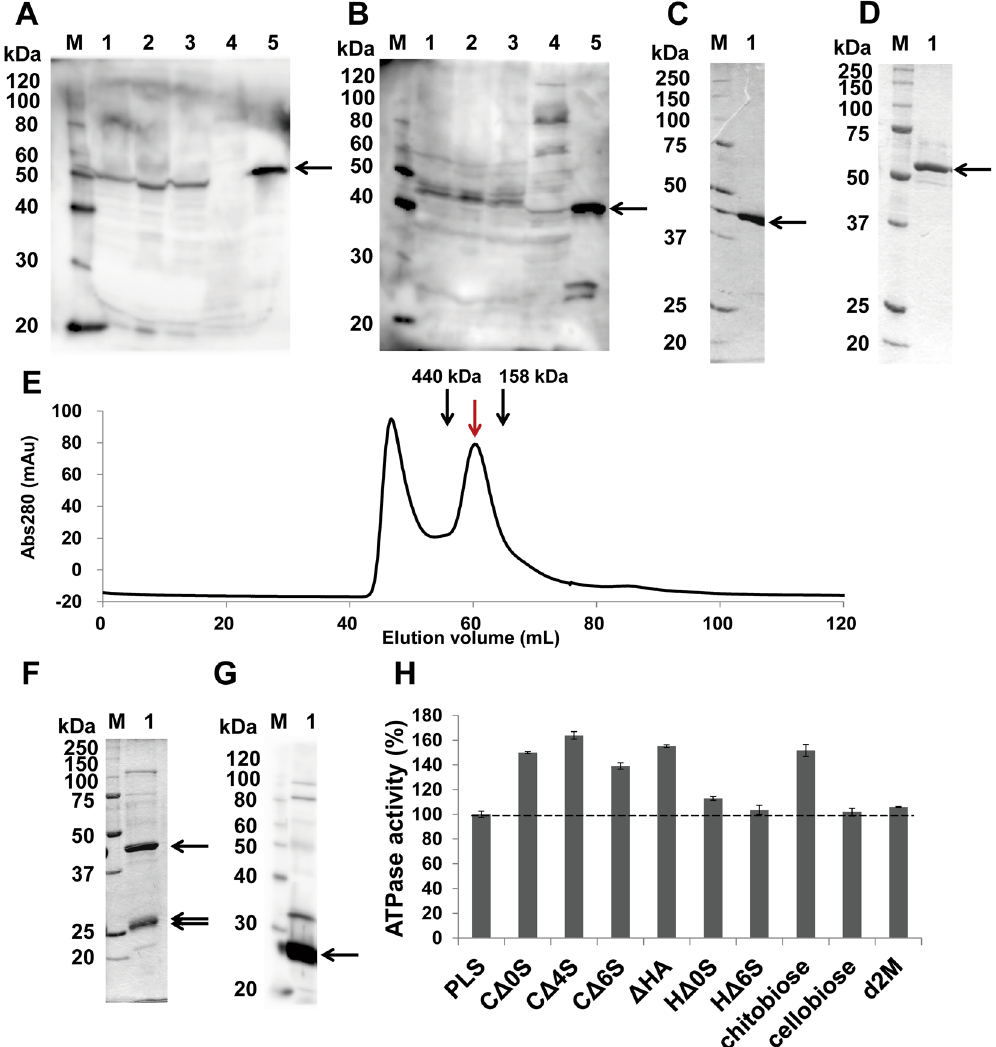
Figure 4. Expression and characterization of binding protein-dependent ABC transporter. SDS-PAGE followed by immunoblotting using anti-Smon0123 antibodies ( A ) and anti-SpyUGL antibodies ( B ). S. moniliformis cells grown in liquid nutrient medium (100 μ l) in the presence or absence of GAG (hyaluronan or chondroitin sulfate ( C ) were collected at OD 600 = 0.37 by centrifugation. The cells were lysed with SDS, and the resultant cell lysates were subjected to immunoblotting for detection of Smon0123 (solute-binding protein) and Smon0127 (UGL) encoded in the GAG genetic cluster. Lane M, protein standards with molecular masses of 120, 100, 80, 60, 50, 40, 30, and 20 kDa used for immunoblotting; lane 1, S. moniliformis cells in the absence of GAG; lane 2, S. moniliformis cells in the presence of hyaluronan; lane 3, S. moniliformis cells in the presence of chondroitin sulfate C; lane 4, E. coli cells in the absence of GAG; lane 5, positive control [purified Smon0123 ( A ) and SagUGL ( B )]. ( C ) and ( D ) SDS-PAGE followed by staining with Coomassie Brilliant Blue (CBB). Lane M, protein standards with molecular masses of 250, 150, 100, 75, 50, 37, 25, and 20 kDa for CBB staining; lane 1, purified Smon0127 ( C ) and Smon0123 ( D ). ( E ) Elution profile of Smon0121-Smon0122(10xHis)/Smon0120- Smon0120 via gel filtration chromatography. Left and right-sided peaks show an aggregate and a tetramer, respectively. Volumes required for elution of the standard ferritin (440 kDa) and aldolase (158 kDa) are indicated by black arrows. ( F ) SDS-PAGE followed by CBB staining. Lane M, protein standards with molecular masses of 250, 150, 100, 75, 50, 37, 25, and 20 kDa; lane 1, purified Smon0121-Smon0122(10xHis)/Smon0120- Smon0120. ( G ) Immunoblotting using anti-histidine tag antibodies. Lane M, protein standards with molecular masses of 120, 100, 80, 60, 50, 40, 30, and 20 kDa; lane 1, purified Smon0121-Smon0122(10xHis)/Smon0120- Smon0120. ( H ) ATPase activity of the Smon0121-Smon0122(10xHis)/Smon0120-Smon0120 in liposomes in the presence or absence of various disaccharides. PLS, proteoliposome without disaccharides; chitobiose, N , N ′ - diacetylchitobiose; d2M, unsaturated alginate disaccharide. The ATPase activity in PLS was considered 100%. Each data represents the average of triplicate individual experiments (means ± standard errors of the